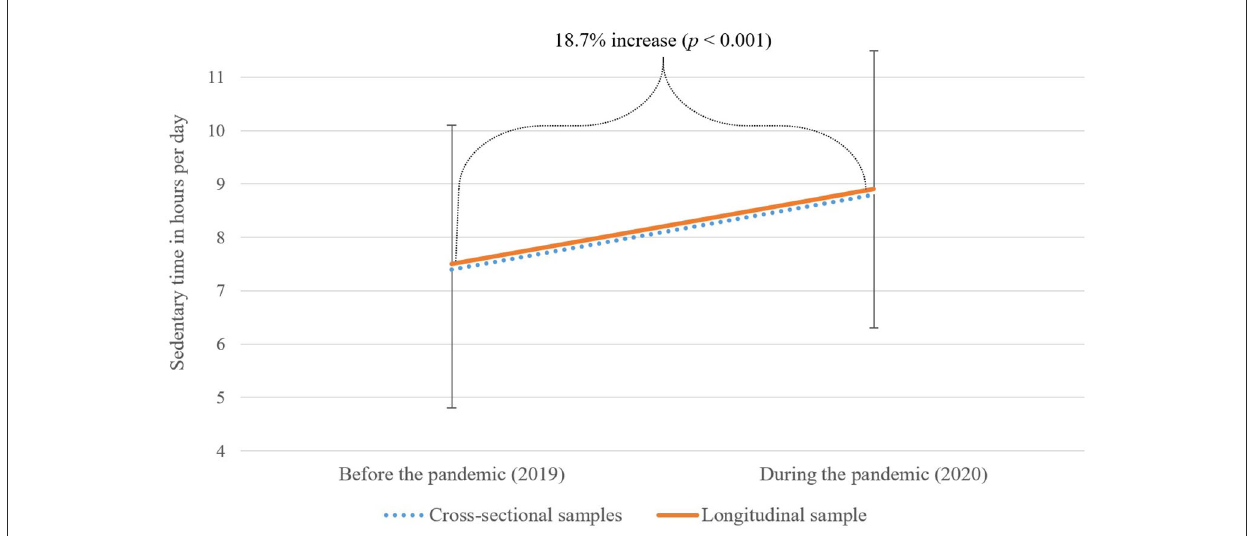
FIGURE1 Sedentary time (ST) of the cross-sectional samples ( n = 3,845 in 2019; n = 2,522 in 2020) and the longitudinal study sample ( n = 378) before and during the COVID-19 pandemic.